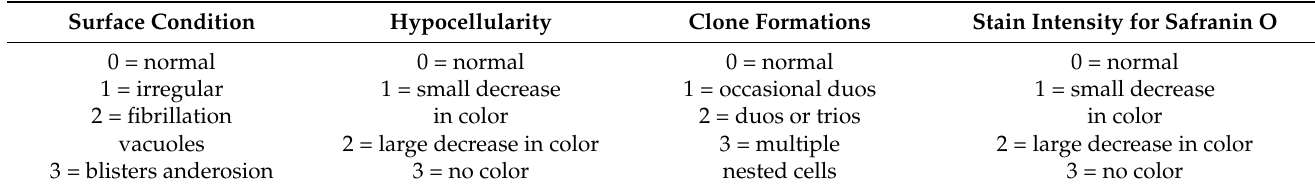
Table 1. Variable scores of the Mankin scoring systems. Surface Condition Hypocellularity Clone Formations Stain Intensity for Safranin